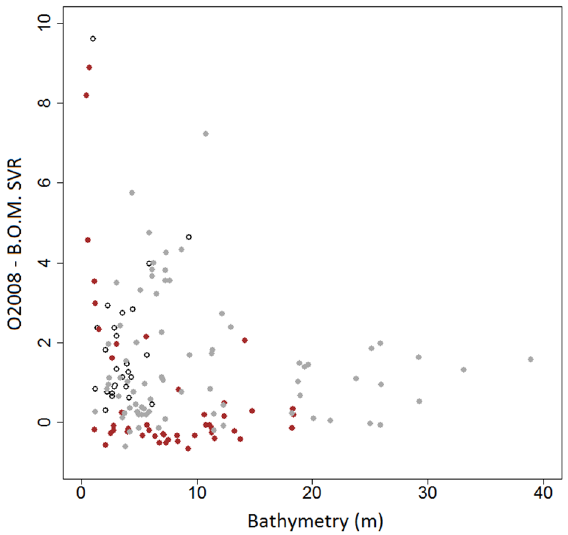
Figure 8. Differences in turbidity estimates between the O2008 model and B.O.M. according to Figure 2. ( a ) Map of the bathymetry (in m) at the Voh ‐ Koné ‐ Pouembout (VKP) lagoon. Points colours